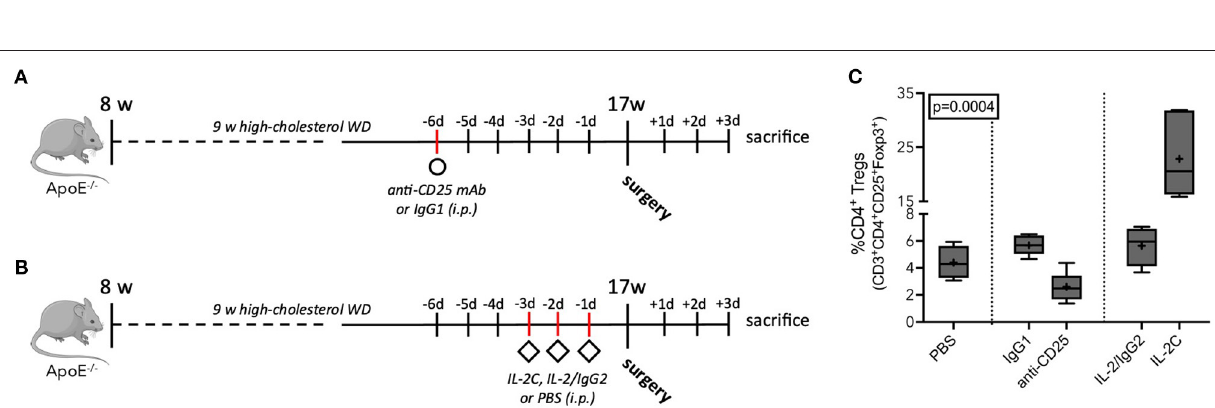
Frontiers in Cardiovascular Medicine |